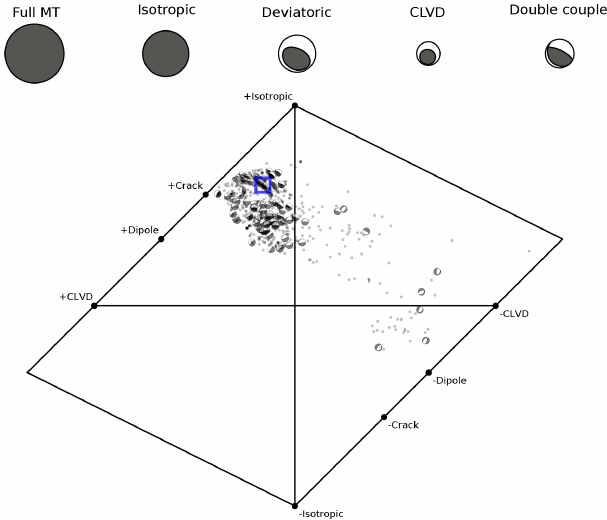
Figure 6. Best moment tensor decomposition (top) and source type plots (bottom) for the 2017 explosion. Top: the moment tensor de- compositions reports the focal sphere for the full moment tensor, and its isotropic and deviatoric components. The deviatoric compo- nent is further decomposed into CLVD and DC terms. The relative size of focal spheres scales with their relative magnitude. Bottom: the source type diagram after Hudson et al. (1989) is used to judge the moment tensor decomposition, illustrating the ensemble of best- fitting solutions. Figure shows both solutions based on all available data, as well as using data subsamples upon bootstrapping. The po- sition of each solution (circles, focal sphere for selected solutions) illustrates the moment tensor (MT) decomposition, while the focal spheres (shown for selected solutions only) illustrate the geometry of the DC term. The decomposition of the best solution is denoted by a blue